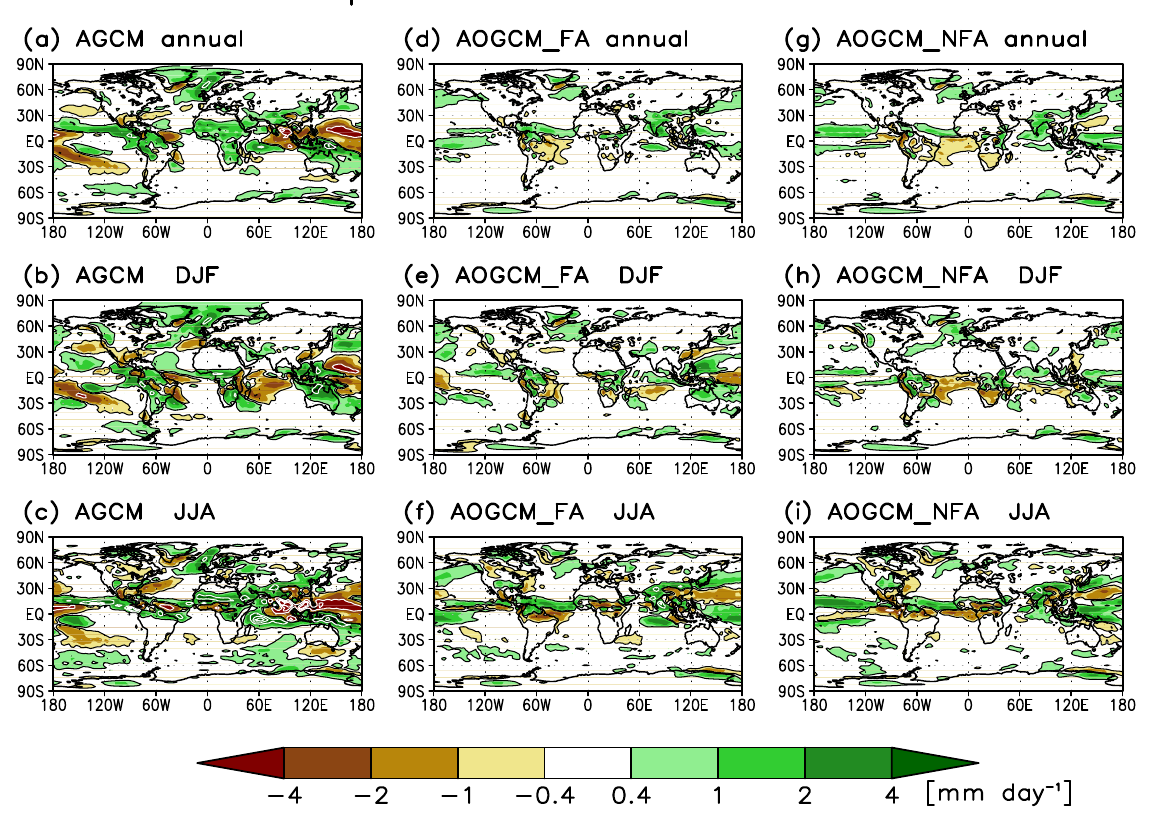
Fig. 7. Same as Fig. 5, but for precipitation rate (mmday − 1 ) . Thin black contour represents ± 0.8, ± 2mmday − 1 and white contour interval is 4mmday − 1 .